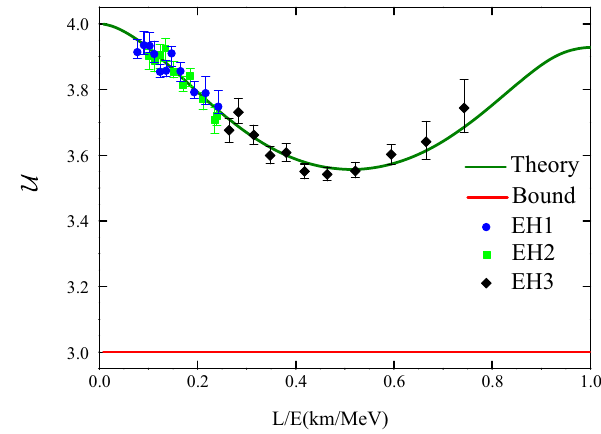
Fig. 3 The total entropic uncertainty ( U ) as a function of the distance traveled per energy L / E with an initial electron flavor state. The olive line represents the theoretical value of the total entropic uncertainty in Eq. (26); the red line corresponds to the lower bound of the total EUR, the right-hand side of Eq. (18), the experiment data are from Daya Bay collaboration [3] in three underground experimental halls (EH1: blue, circle; EH2: green, square; EH3: black,